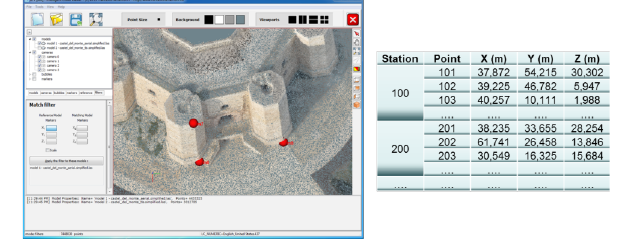
Figure 23. Definition of the section plane